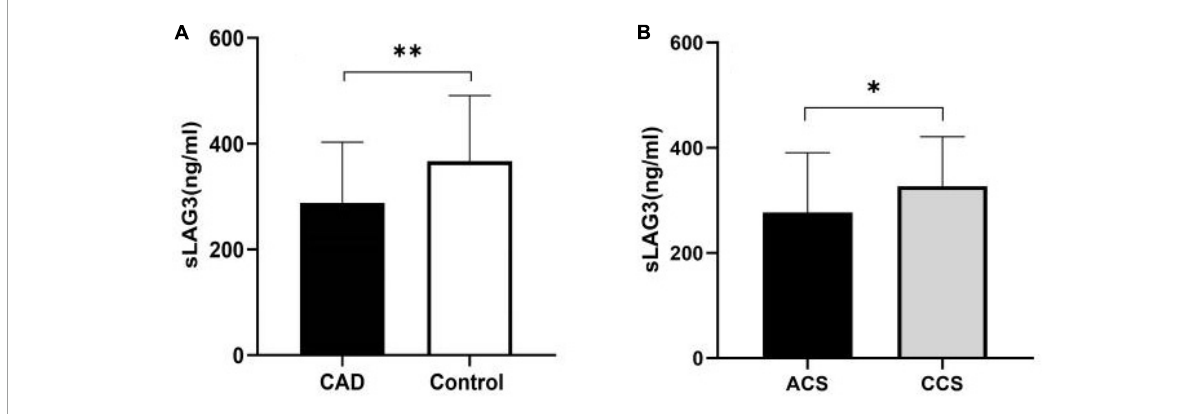
FIGURE1 The level of the soluble lymphocyte activation gene-3 (sLAG3) in patients with coronary artery disease (CAD). (A) The sLAG3 was markedly reduced in patients with CAD. (B) The similar Level of sLAG3 between acute coronary syndrome (ACS) subgroup and chronic coronary syndrome (CCS) subgroup. The sLAG3 was compared using Mann-Whitney U -tests. ∗∗ P < 0.05, ∗ P > 0.05.